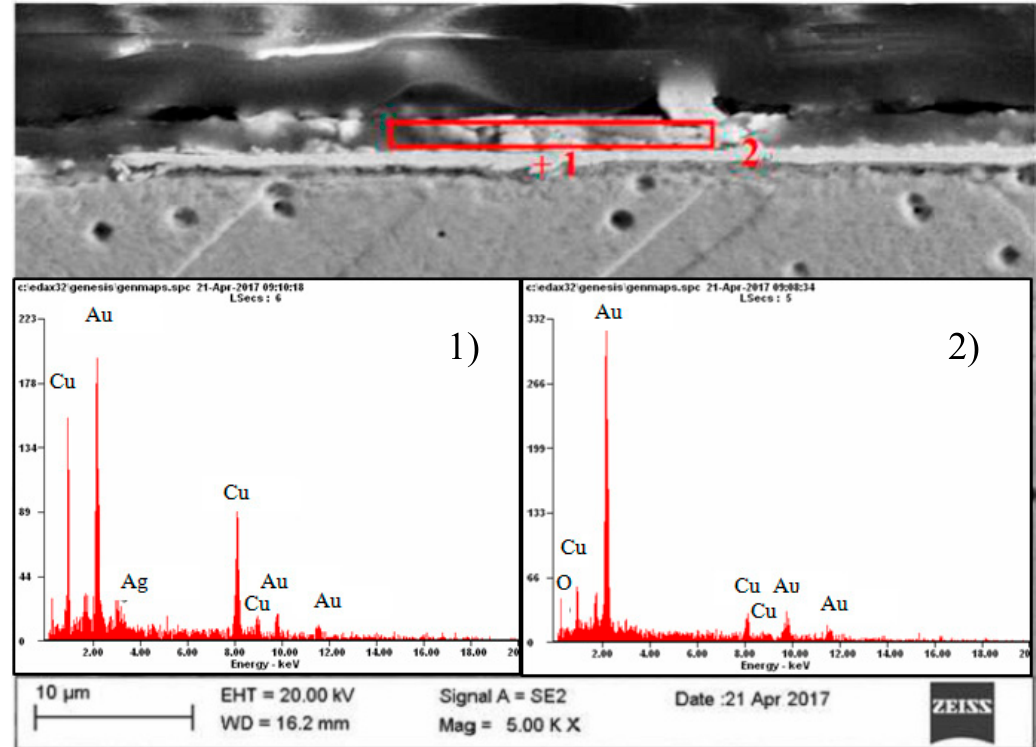
Figure 8. Results of point ( 1 ) and surface ( 2 ) microanalysis of the chemical composition of the coating layer on gold electrolytically deposited on copper. Table 1. Results of microanalysis of the chemical composition of the coating layer on a copper electrode with electrolytically-deposited gold.